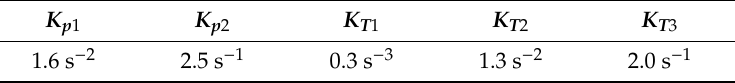
Table 2. Feedback linearization (FBL) controller parameters [6].